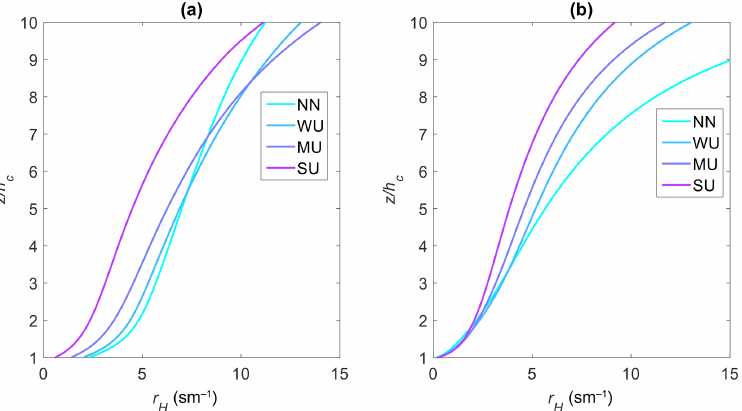
Figure 6. (a) The variation of r H with height across stability according to the improved formulation as given by Eq. (13); (b) similar variations of r H computed from the LES repeated again for comparison.